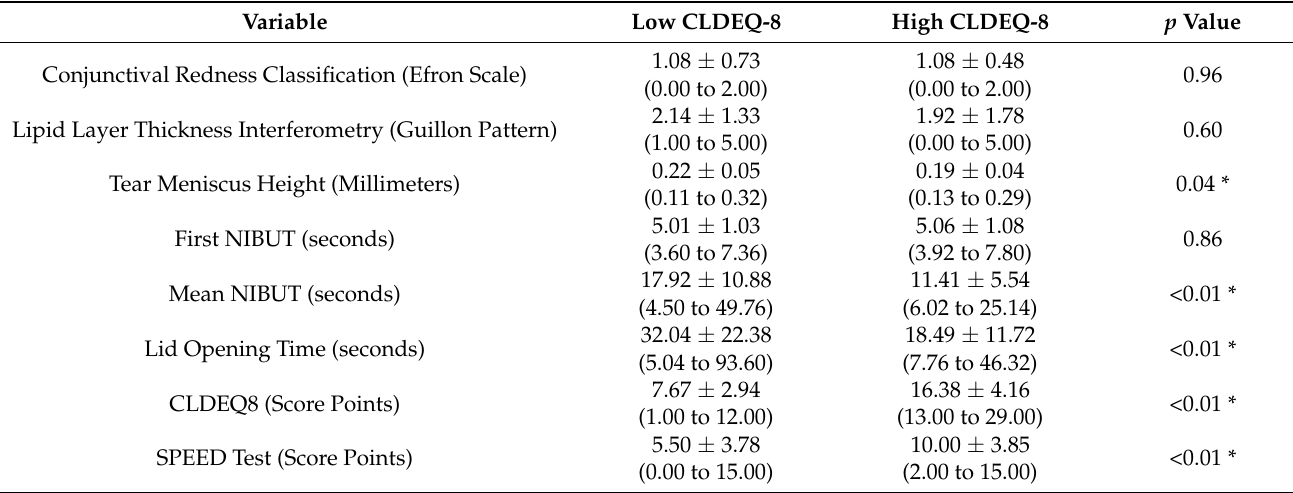
Table 1. Baseline outcomes divided by CLDEQ-8 group.